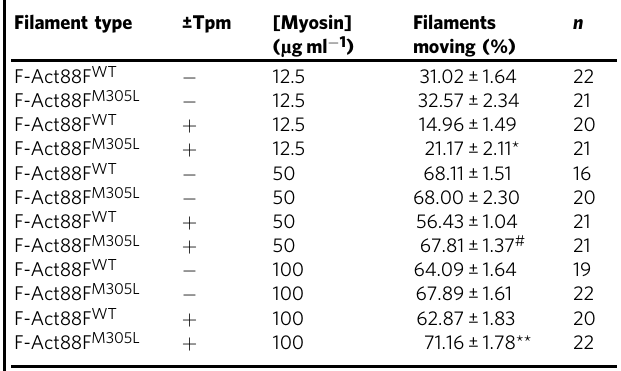
Table 3 Flight indices of Act88F > Act57B WT and Act88F